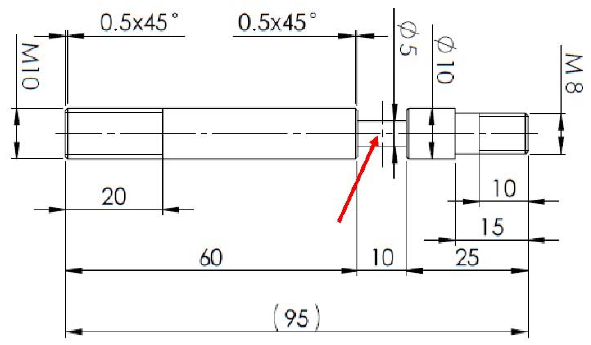
Figure 3. Drawing of a test specimen.